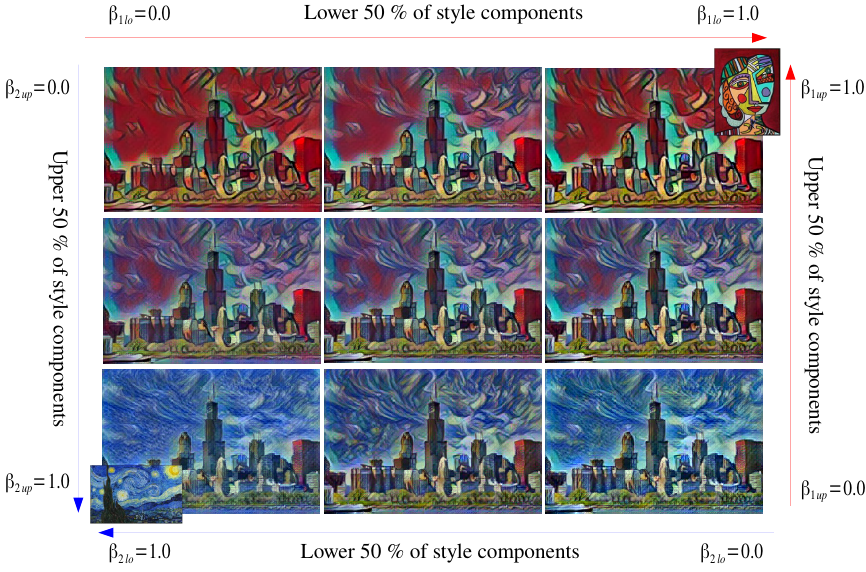
Figure 8. Examples of the component-wise style interpolation of two